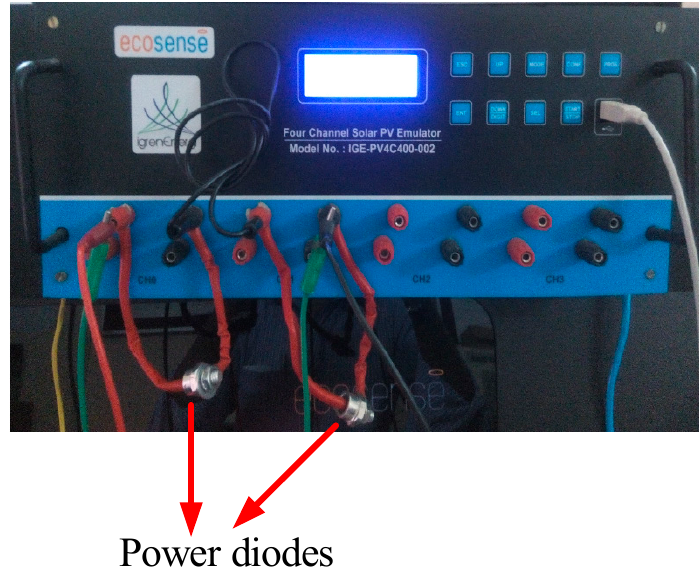
Figure 23. PV emulator connection for partial shading condition.